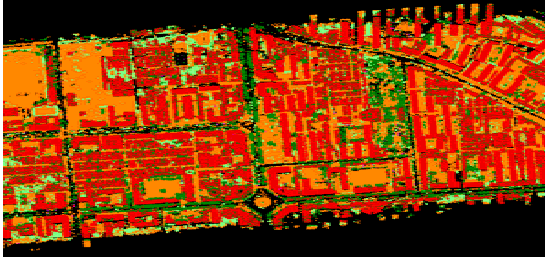
Figure 3(b). Dunhuang data classification result, with: ground, low vegetation, tree,